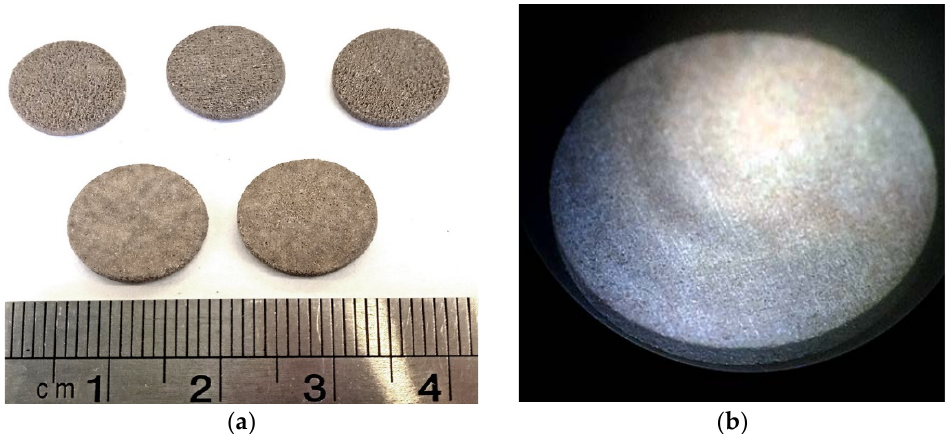
Figure 8. Images of BCZT samples manufactured by BJ for the functional property measurements: ( a ) samples after sintering; ( b ) samples after silver electrode coating.